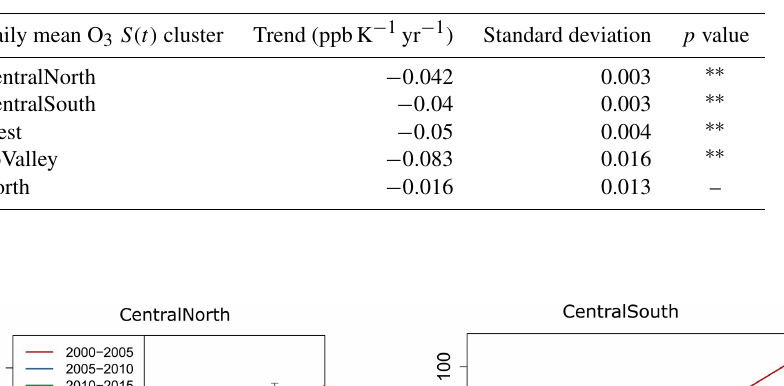
Table 3. Linear trends of the O 3 –temperature slope (based on daily maximum values) for the daily mean O 3 S(t) clusters for the time period 2000–2015: ∗∗ indicates a highly significant trend ( p value < 0.01), and – indicates a nonsignificant trend ( p value > 0.05).